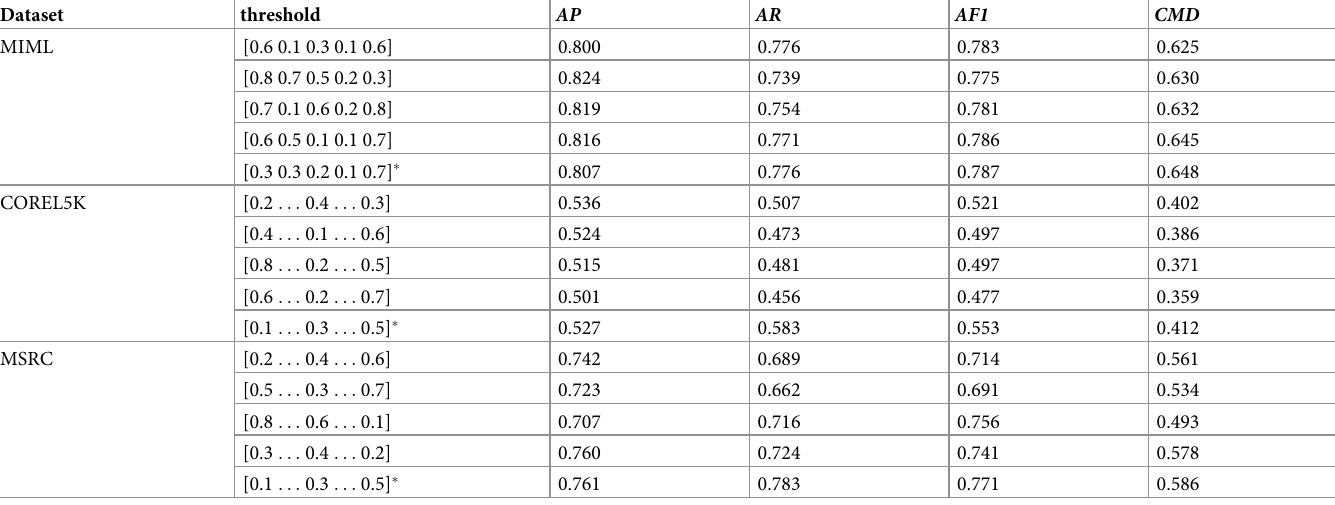
Table 2. Experimental results for each group of thresholds.